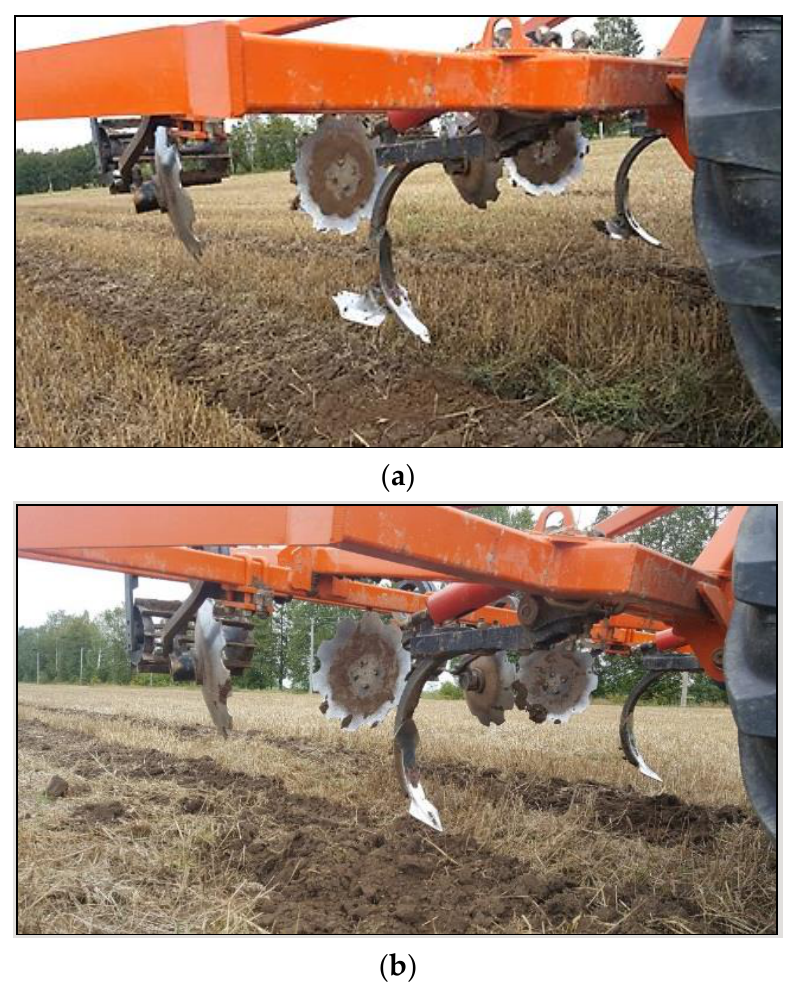
Figure 1. Winged tine shape ( a ) and narrow (double end) tine shape ( b ). The renovation of tramlines soil physical state defined by soil structure and soil surface levelling must be accomplished with lowest fuel consumption required to achieve suffi- ciently correct renovation quality. The determination of initial soil conditions in tramlines was done by measurements of soil surface roughness, bulk density, and soil penetration resistance. After renovation of tramlines the estimating of soil surface and bottom geometry, soil aggregate proportion ratio (ks) and determination of fuel consumption (FC) by three replications by each aggregate regime mode was